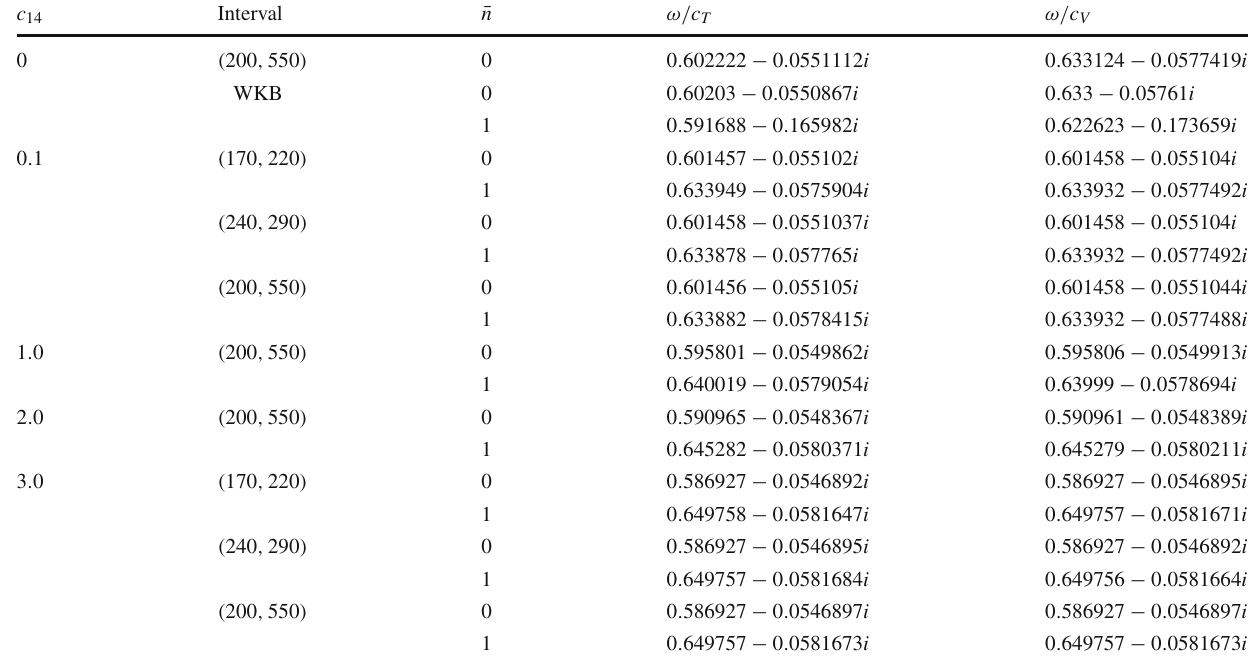
Table 4 The quasinormal frequencies ω/ c T and ω/ c V for different coupling c 14 with the metric parameters m = 1, n = L = 5, and √ c T = c V = 1 / 1 − c + . By employing the finite difference method and Prony method successively, the extracted complex frequencies are